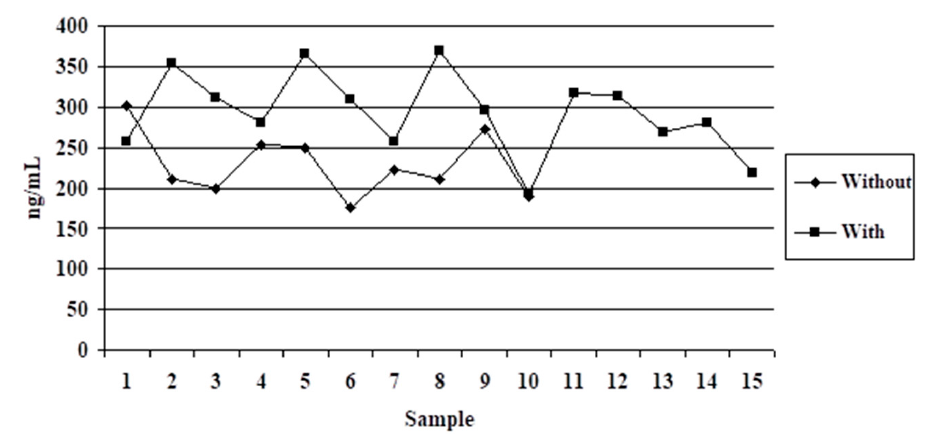
Figure 2. Serotonin dynamics in dogs with or without owner.